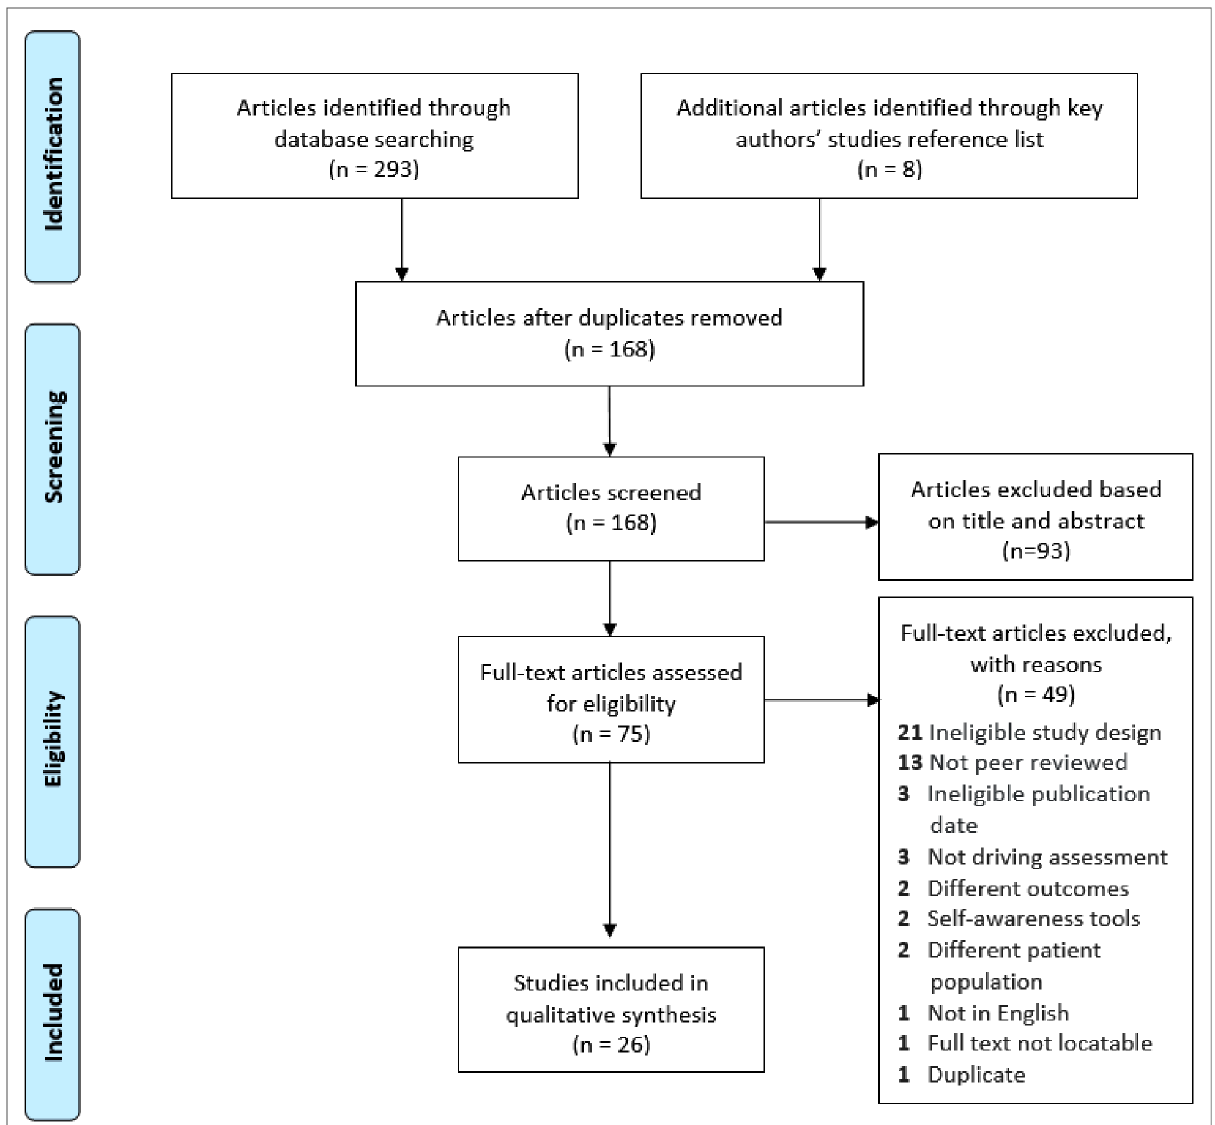
FIGURE 1 Flowchart of the systematic literature